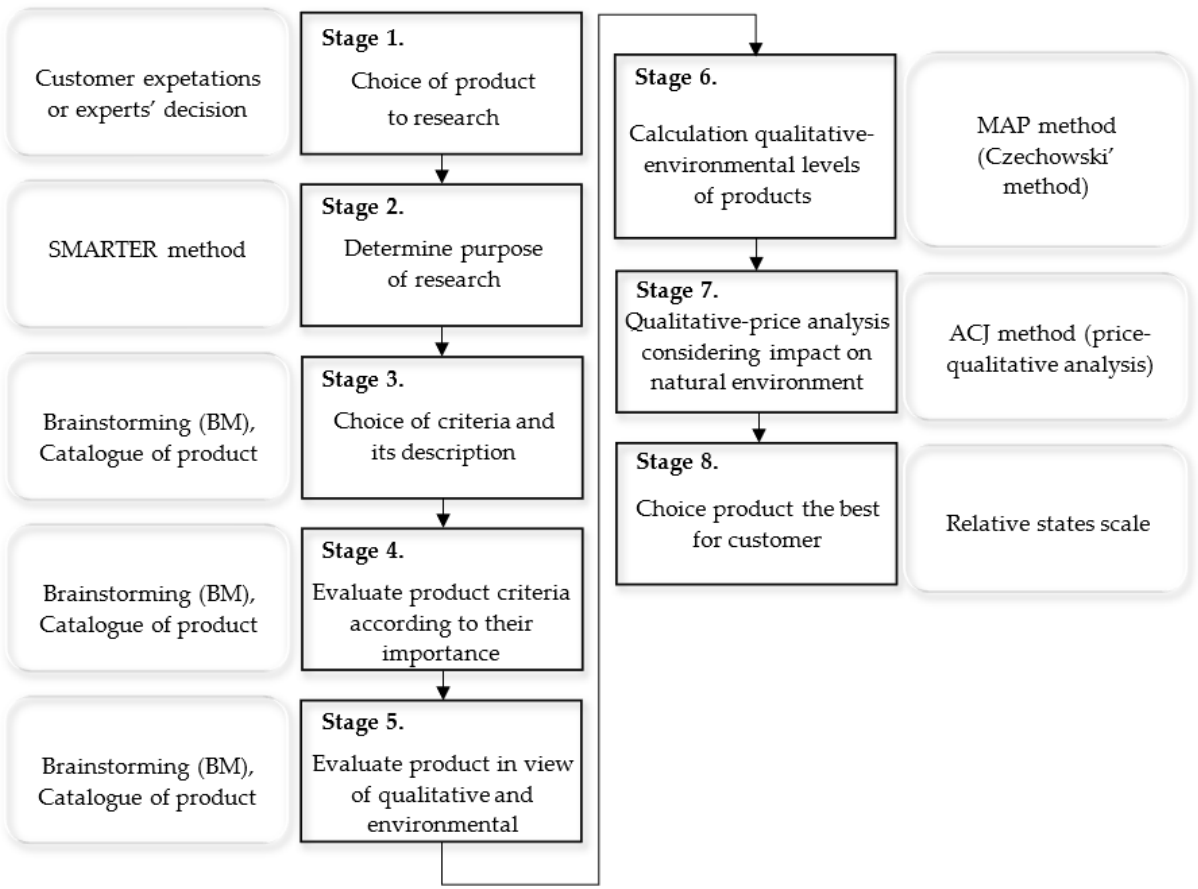
Figure 2. Algorithm of the method with techniques supporting its realization.